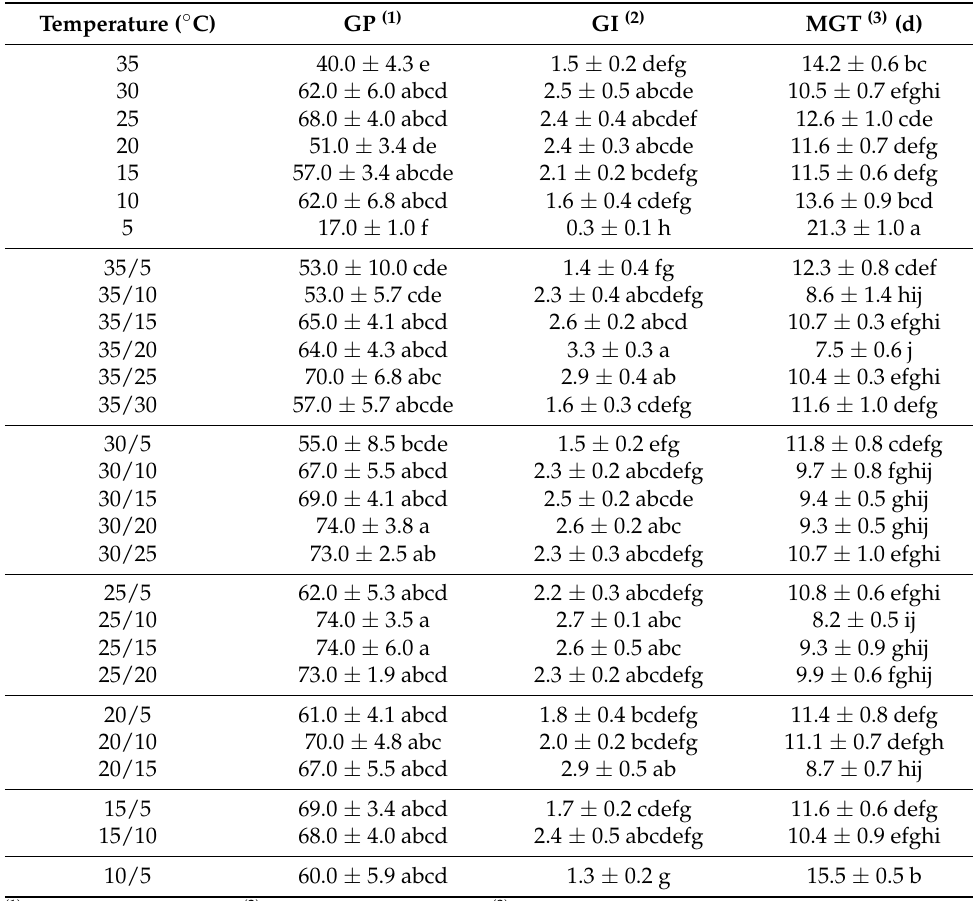
Table 5. Germination (mean ± standard error) of F. rhynchophylla seeds at different temperatures after 8 weeks cold